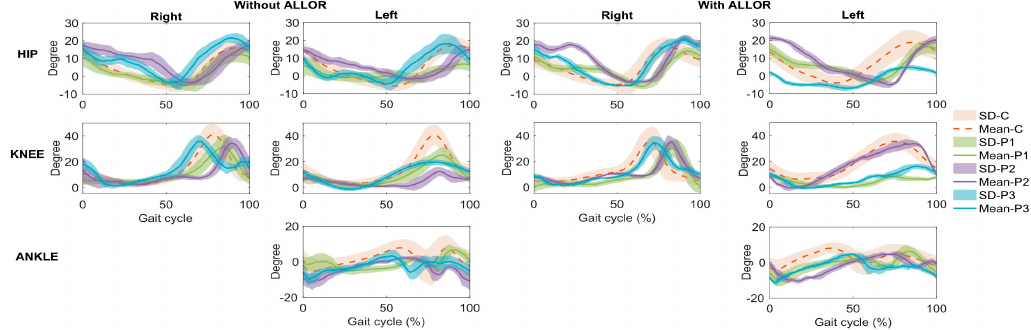
Figure 3. Effect of the use of the walker on the muscular activation of patients P1 and P2. ( a ) Muscle activation on different levels during gait without ALLOR; ( b ) with ALLOR; ( c ) Lateral synergy on muscle activation without ALLOR; ( d ) with ALLOR; ( e ) Muscle fatigability without ALLOR; ( f ) with ALLOR. n.s, non-significant difference; * p -value < 0.05; *** p -value < 0.001.